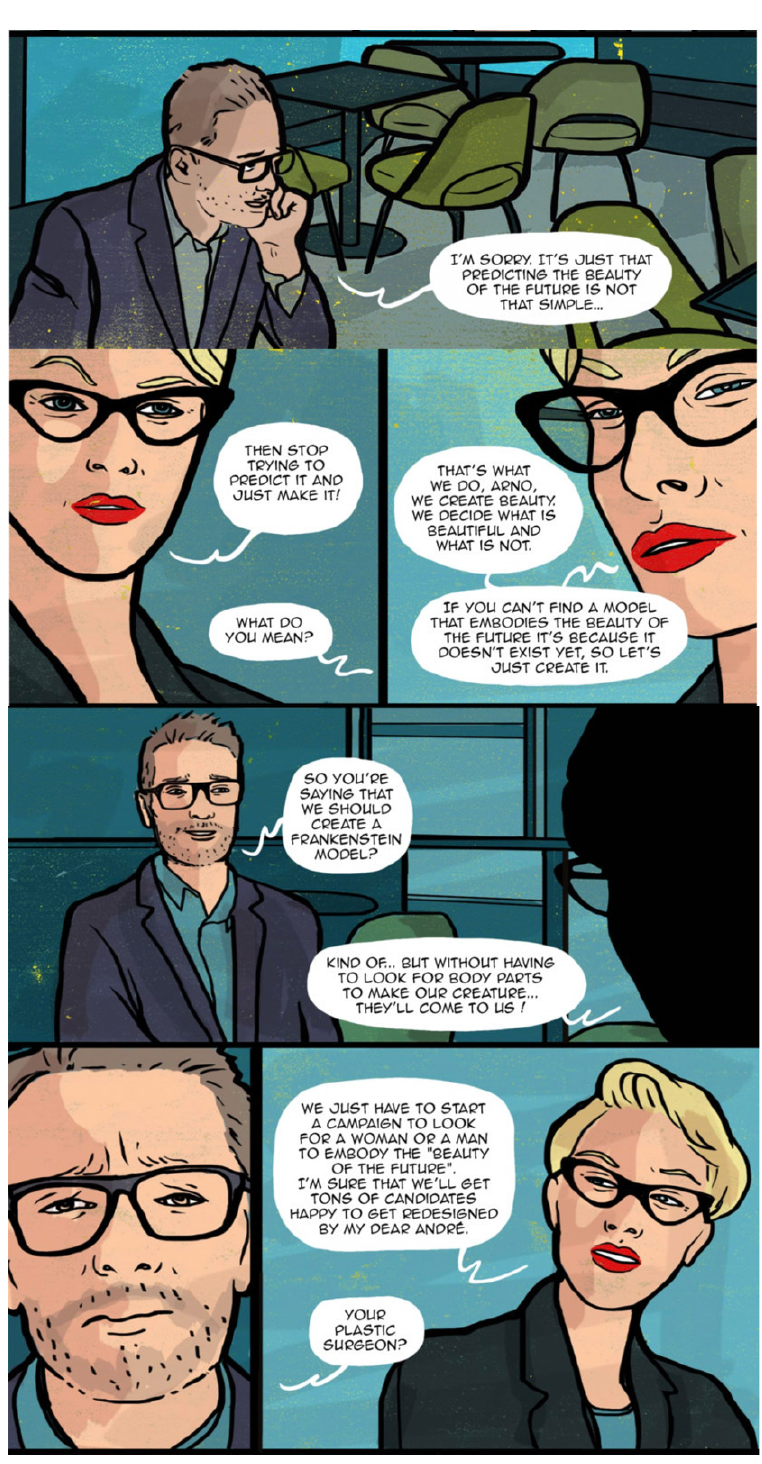
Figure 3: Episode 4: “Let’s just create